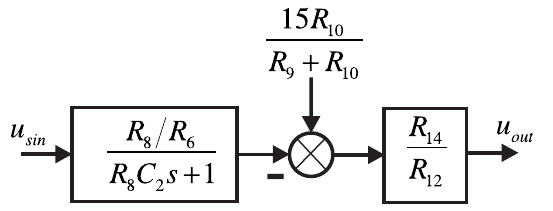
Figure 10. The small signal extracting system structure frame in the detecting components.